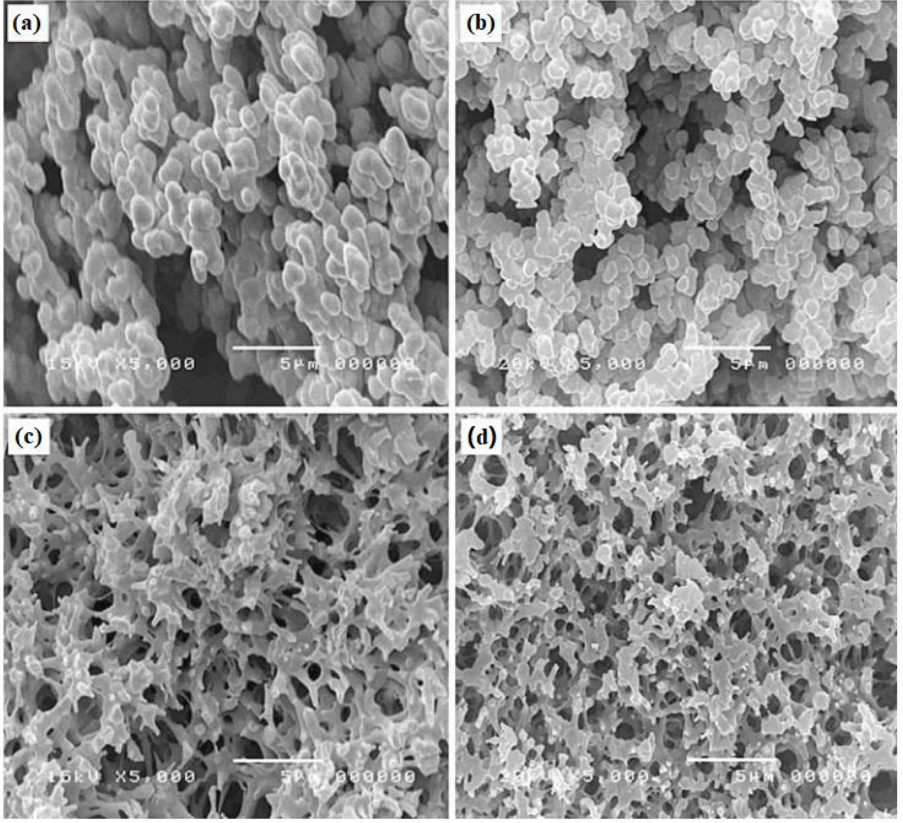
Figure 20. SEM images of carbon aerogels at ( a ) 20 wt% monomer (cured), ( b ) 20 wt% monomer (uncured), ( c ) 40 wt% monomer (cured), and ( d ) 40 wt% monomer (uncured) (reproduced from the work in [33] with permission).